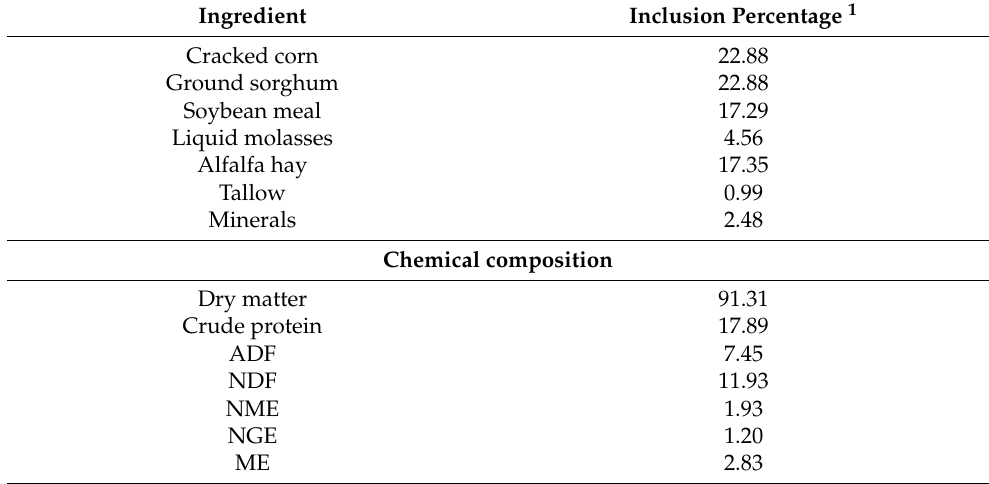
Table 1. Ingredients and chemical composition of the